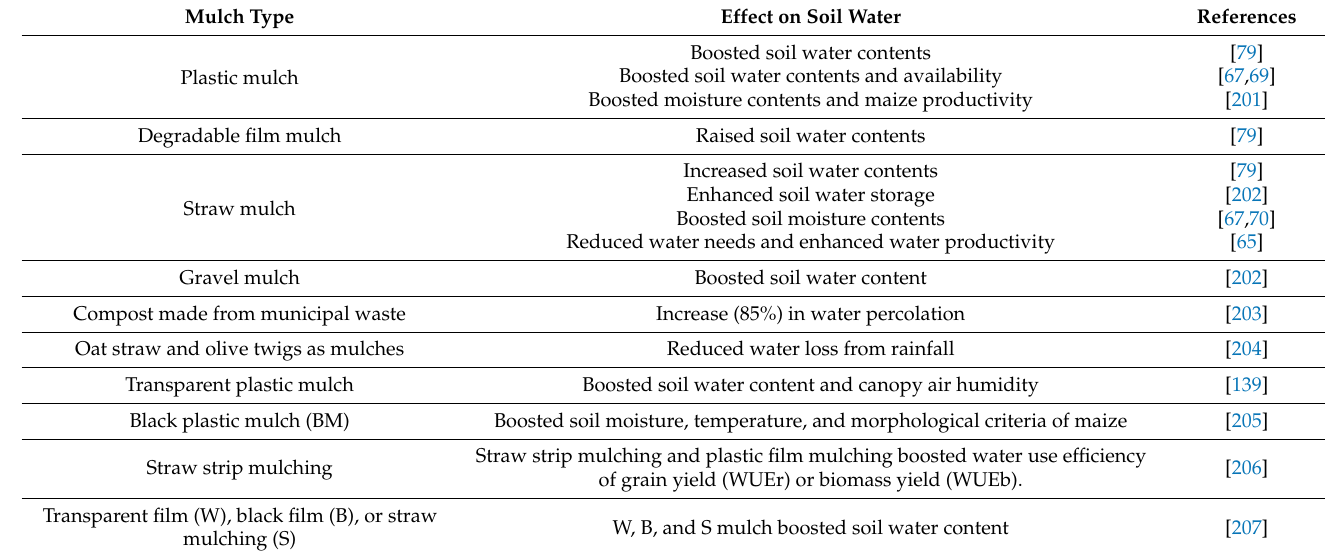
Table 5. Effect of various mulches on soil water